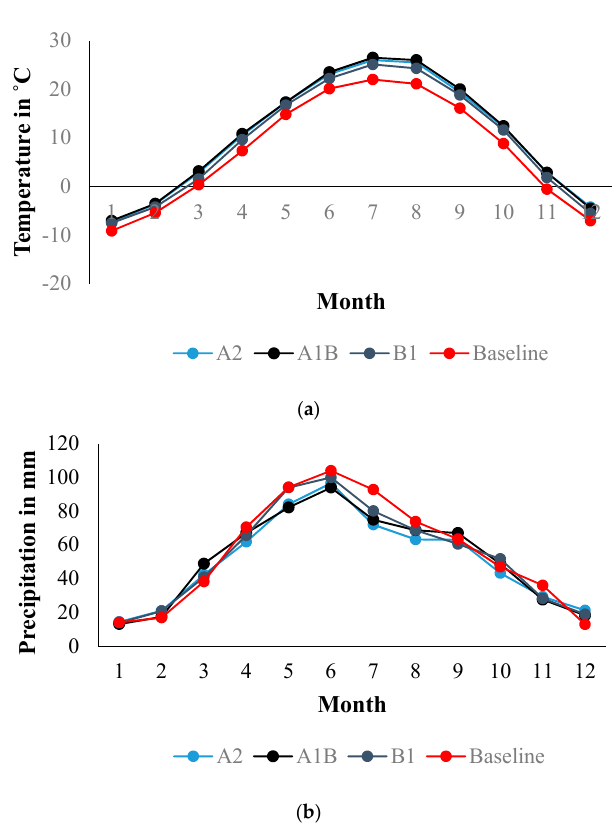
Figure 3. Monthly values observed for ( a ) temperature in °C; and ( b ) precipitation in mm for all three climate change scenarios and baseline time period.